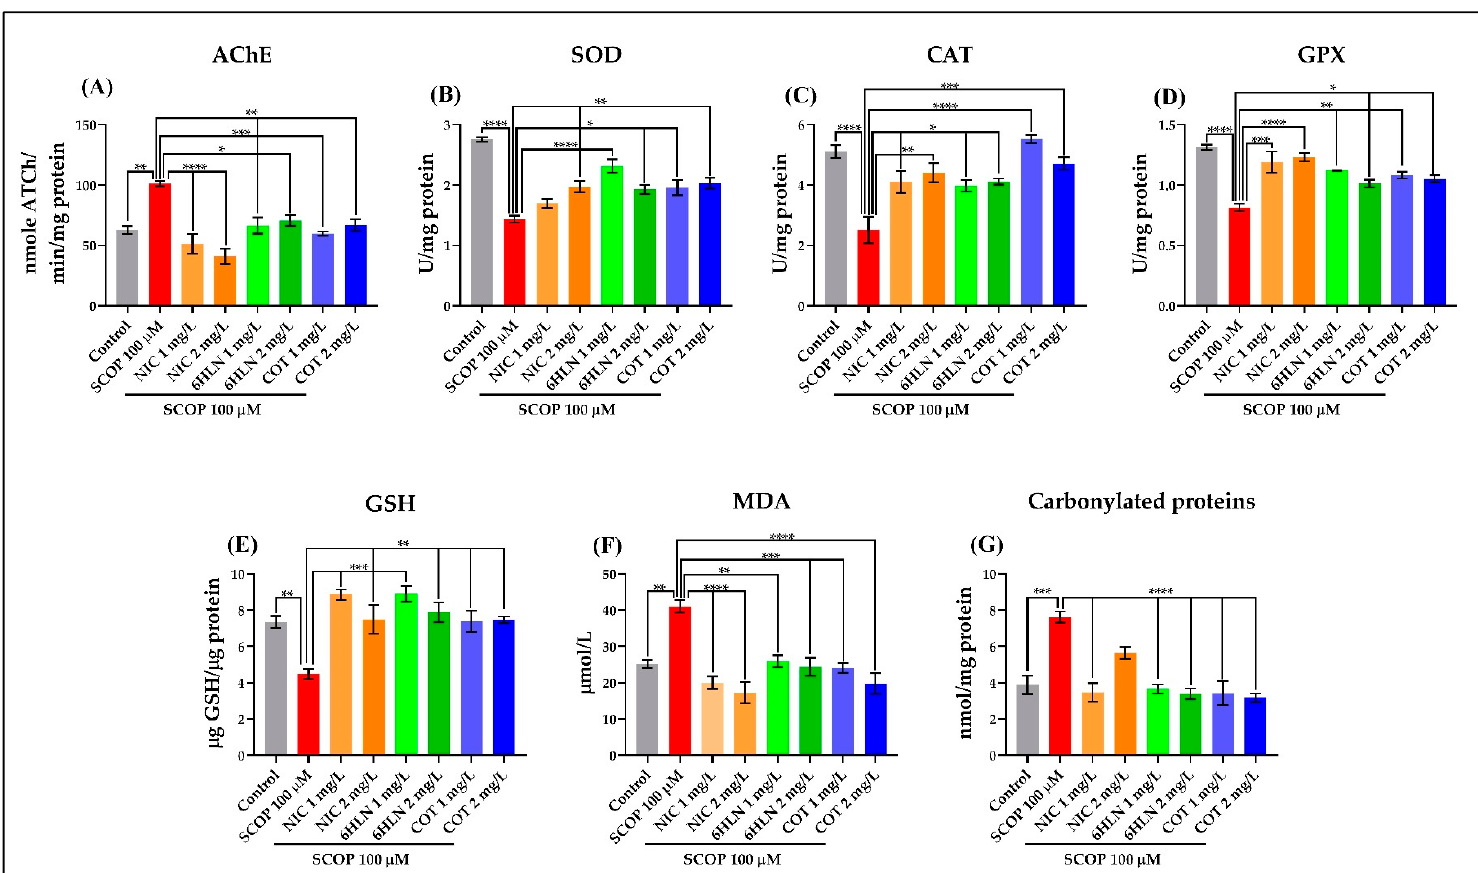
Figure 6. The effects of nicotine (NIC), 6-hydroxy-L-nicotine (6HLN), and cotinine (COT) (1 and 2 mg/L) administration in scopolamine (SCOP)-treated zebrafish on acetylcholine esterase (AChE)- ( A ), superoxide dismutase (SOD)- ( B ), catalase (CAT)- ( C ) and glutathione peroxidase (GPX)- ( D ) specific activities and the content of glutathione (GSH) ( E ), malondialdehyde (MDA) ( F ) and carbonylated proteins ( G ). The values are expressed as means ± S.E.M. ( n = 3). ANOVA analysis revealed overall significant differences between the experimental groups for ( A ) F(7,16) = 11.5, p < 0.0001, ( B ) F(7,16) = 10.15, p < 0.0001, ( C ) F(7,16) = 11.31, p < 0.0001, ( D ) F(7,16) = 14.22, p < 0.0001, ( E ) F(7,16) = 8.541, p < 0.001, ( F ) F(7,16) = 12.39, p < 0.0001 and ( G ) F(7,16) = 14.53, p < 0.0001. For Tukey posthoc analyses—**** p < 0.0001, *** p < 0.001, ** p < 0.01 and * p < 0.05.